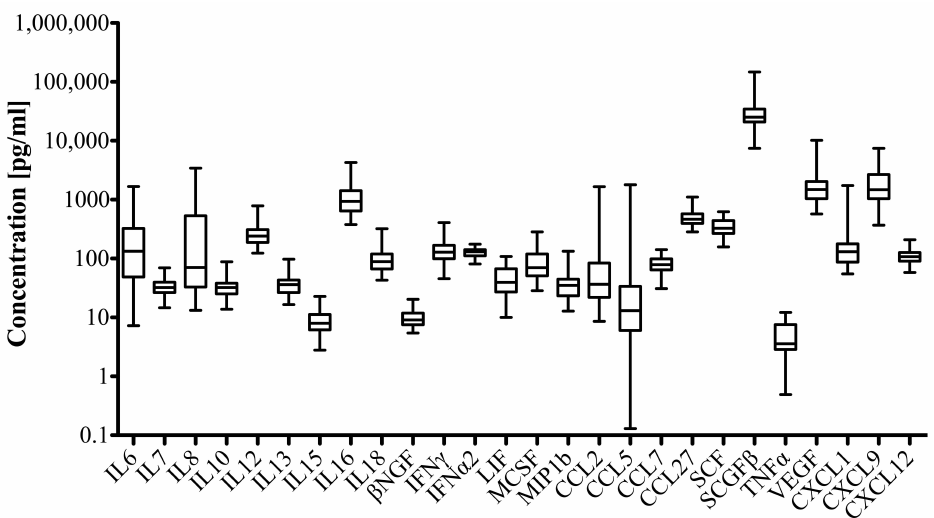
Figure 2. Cytokine pattern in synovial fluid (SF) of patients with knee osteoarthritis. The Pro-Human Cytokine Multiplex Assay (Bio-Rad) was used to analyze the cytokines in SF samples. Cytokine and chemokine concentrations were calculated by reference to the standard curve. The sensitivity of the multiplex kit was < 5 pg / mL. Data are presented as box and whisker plot showing median (interquartile range; IQR) values (box) and minimum to maximal values